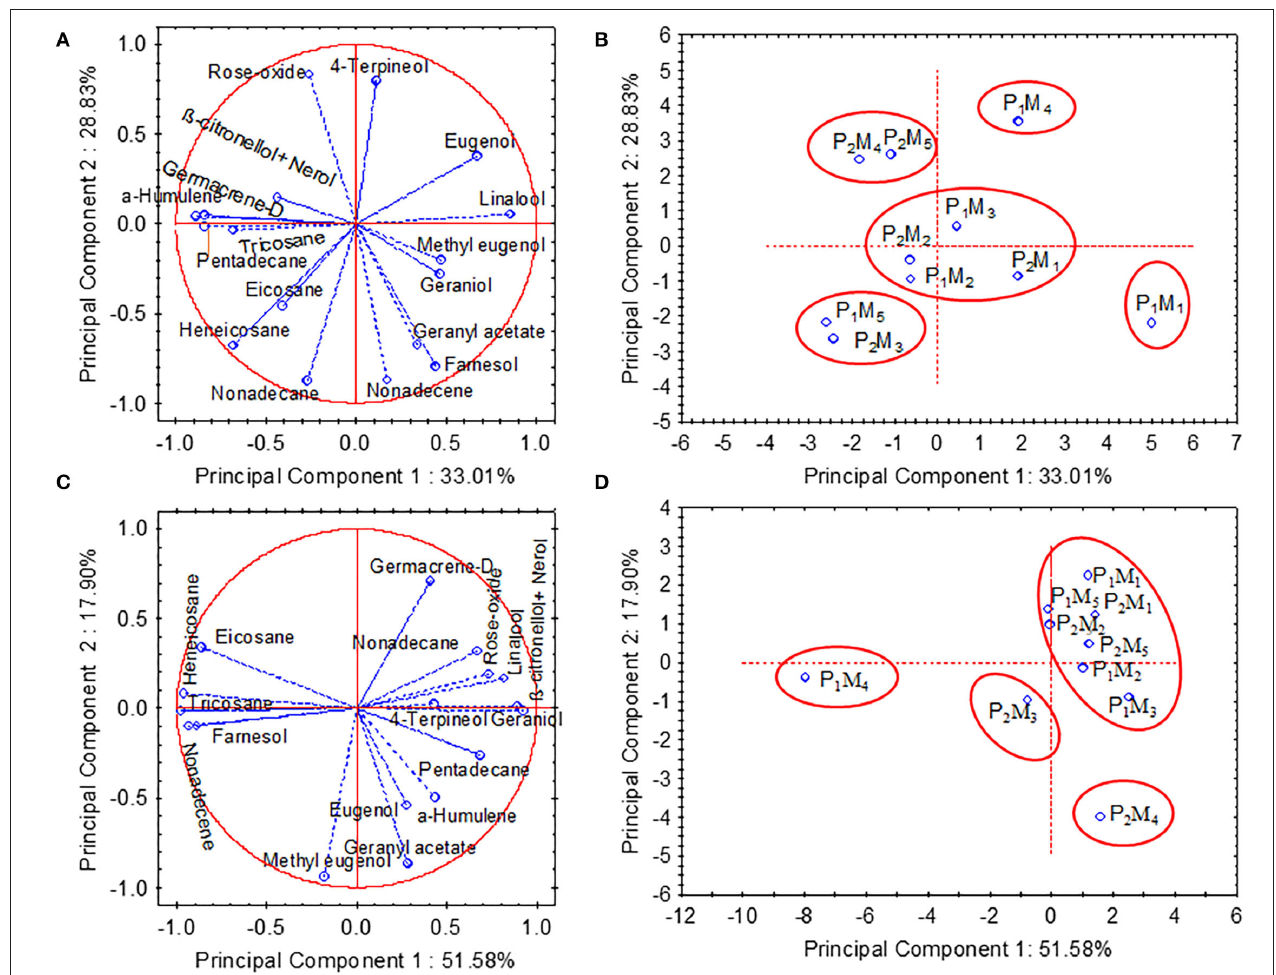
FIGURE 4 | Principal components analysis (PCA) of the components identified in the essential oil of damask rose for the growing seasons of 2015–2016 (A,B) and 2016–2017 (C,D) . P 1 , Ground-level pruning; P 2 , Ground level-pruning + top pruning; M 1 , Ground-level pruning during June; M 2 , Ground-level pruning during July; M 3 , Ground-level pruning during August; M 4 , Ground-level pruning during September; M 5 , Ground-level pruning during